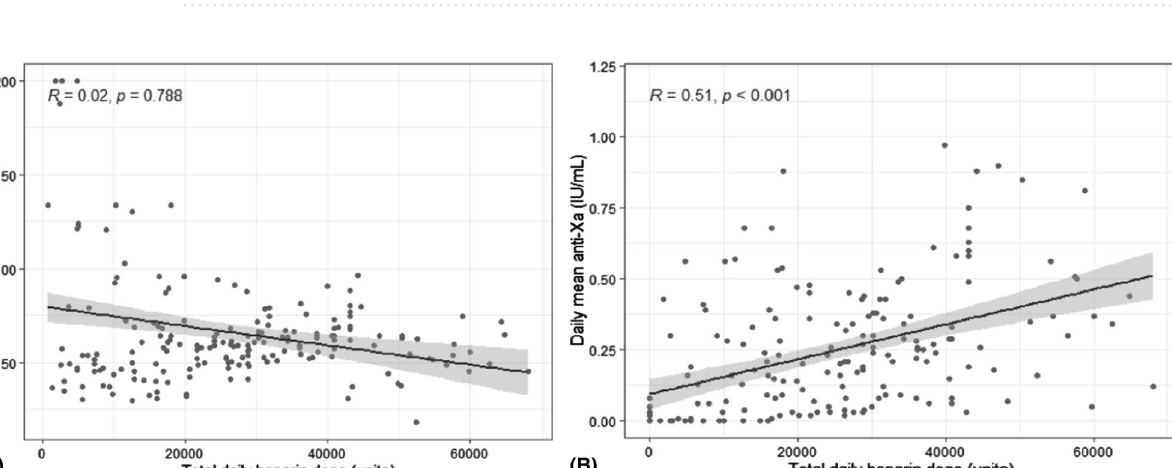
Table 2. Daily first week conventional coagulation and biochemical tests.